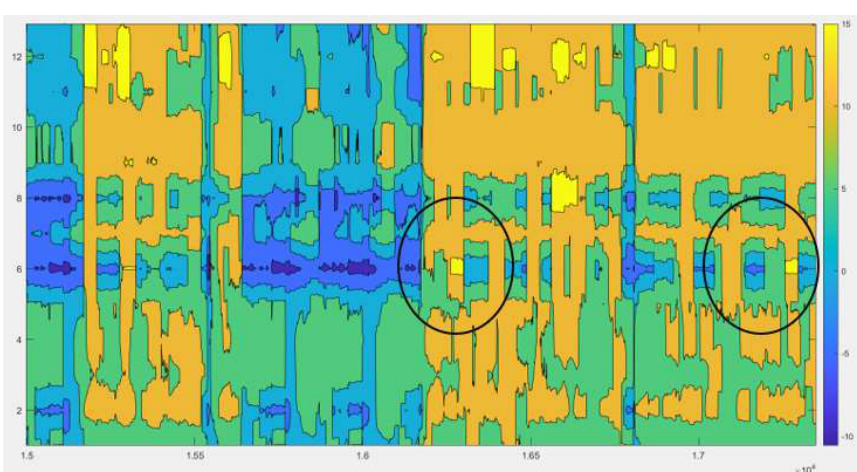
Figure 3. Contribution plot of Q in faulty states.